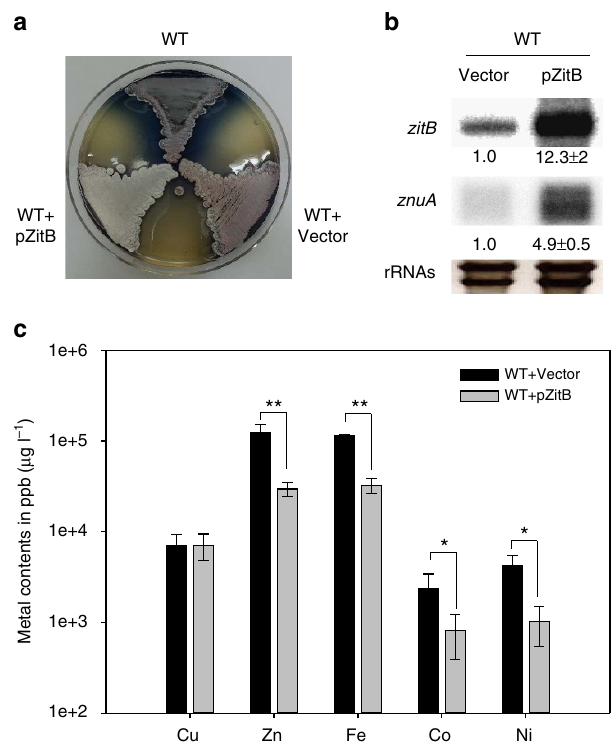
Figure 2 | Overexpression of zitB hinders differentiation and causes a decrease in the content of Zn as well as Fe, Co and Ni. ( a ) The ermEp::zitB construct on pSET162 plasmid (pZitB) was introduced into the chromosome of the wild-type S. coelicolor . The pZitB containing strain showed defect in sporulation (white phenotype) and antibiotic production, whereas the wild-type strain with or without the empty vector (pSET) demonstrated grey spore formation and blue antibiotic production. ( b ) Expression of the zitB and znuA genes in pZitB containing strain. The zitB and znuA transcripts were analysed by S1 mapping. The band intensity was quantified and presented as relative values obtained from three independent experiments and measured with P values of o 0.001 by Student’s t -test. ( c ) Intracellular amounts of divalent cations (Cu, Zn, Fe, Co and Ni) in the wild-type cells with empty pSET162 vector or pZitB, as assayed by ICP-MS analysis. Mn and Cd were not detected. Average values from three biologically independent samples were presented in ppb ( m g per litre wet mycelium) with error bars representing s.d.’s. * and ** indicate measurements with P values of o 0.05 and 0.001, respectively, by Student’s t